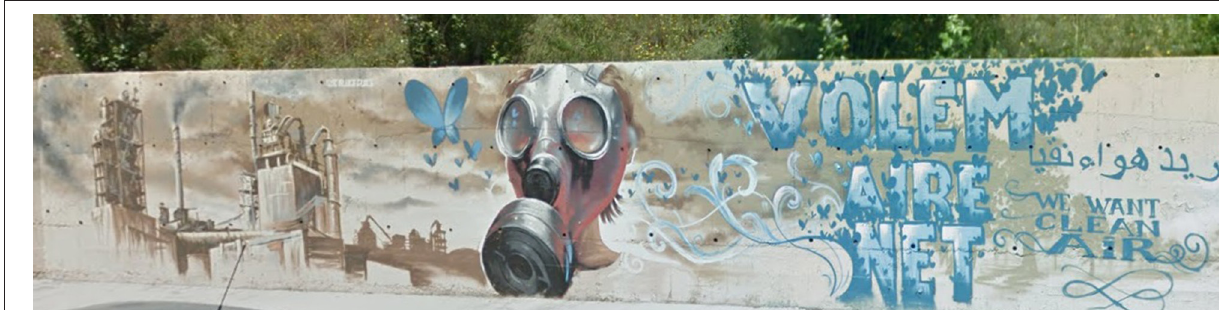
FIGURE 1 | Street art against RDF in Can Sant Joan. Source: own picture.